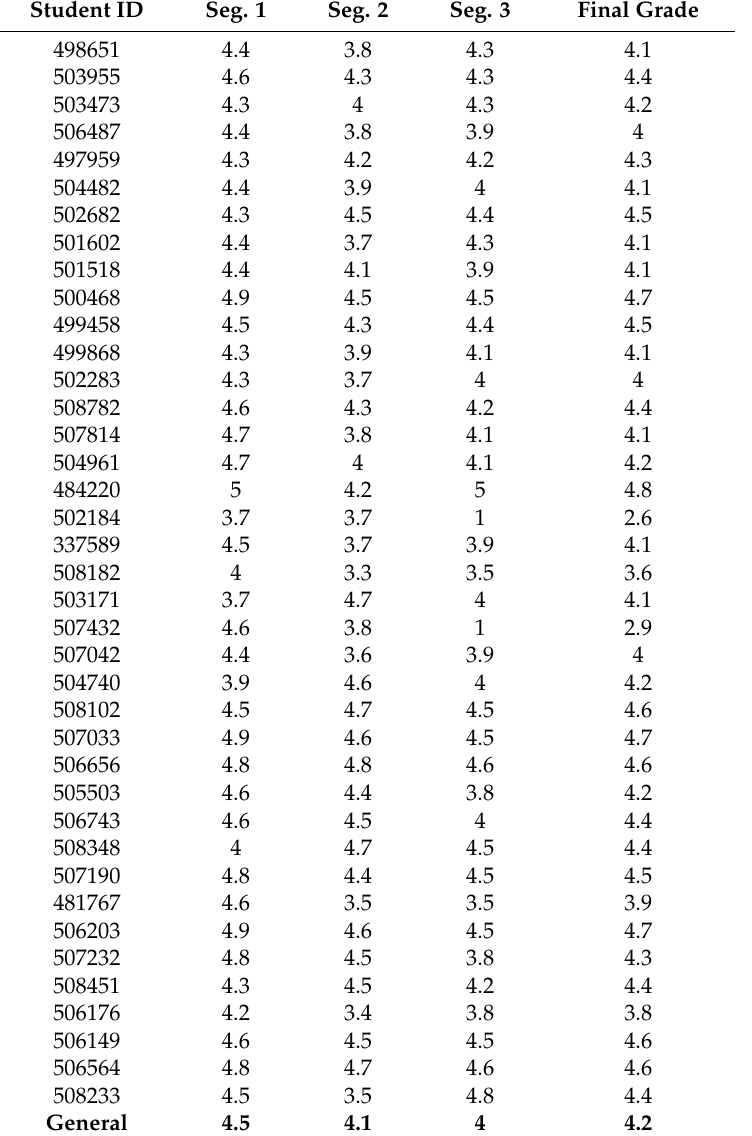
Table 2 details the grades and averages obtained by the test group in the three segments. Table 2. Segment and general averages obtained by